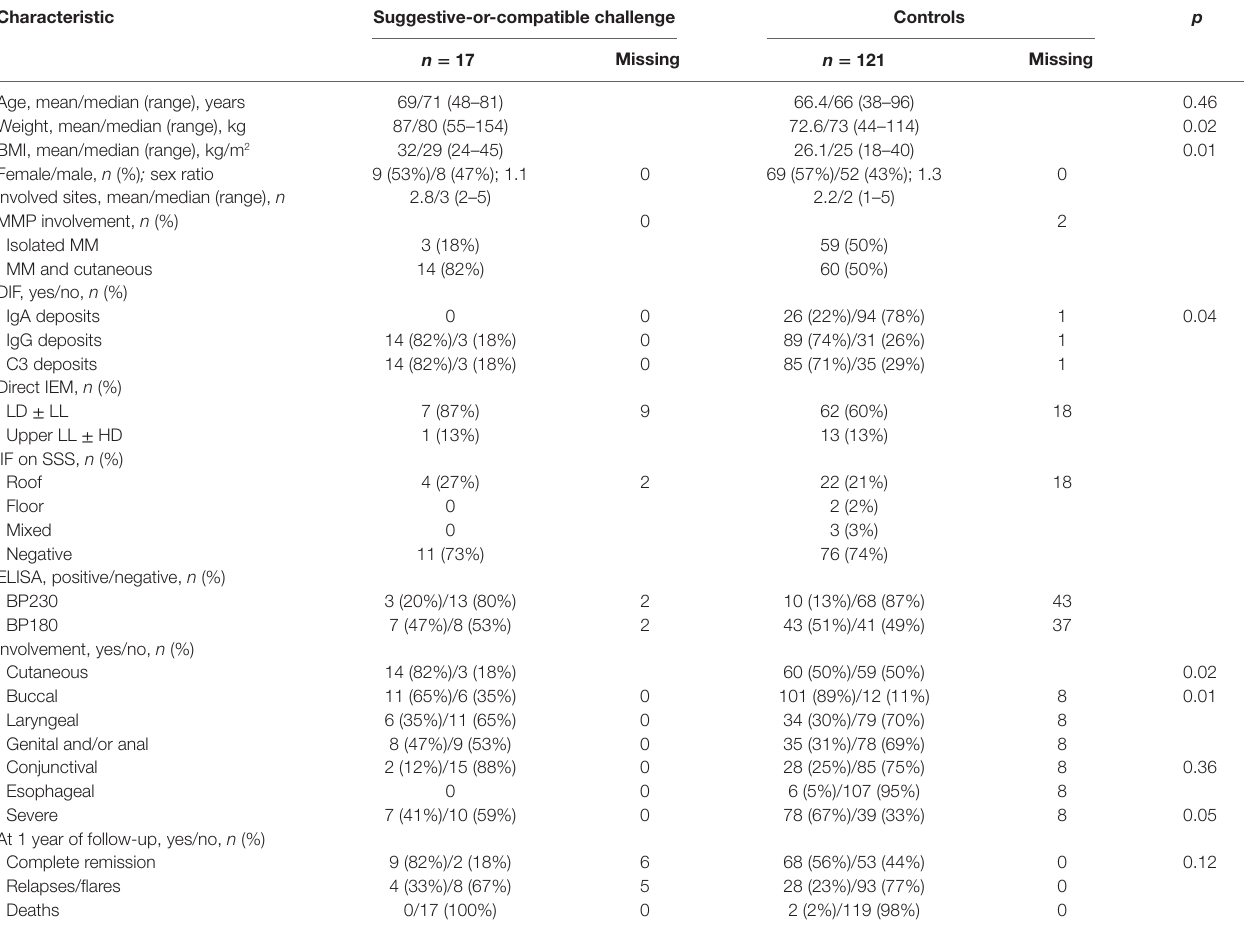
Table 4 | Characteristics and comparisons of suggestive-or-compatible challenge vs. never-gliptin-treated control MMP groups. characteristic suggestive-or-compatible